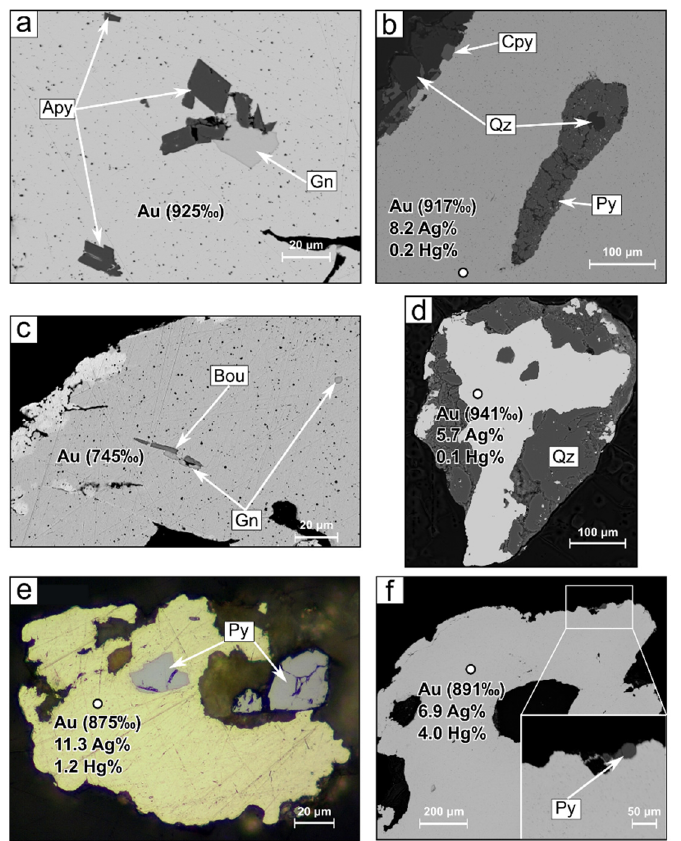
Figure 8. BSE and reflected light microscopy images of mineral inclusions in contact with native gold in Pureo particles. Composition and fineness of the hosting native gold is shown. ( a ) Arsenopyrite (Apy) and galena (Gn) in the particle core. ( b ) Pyrite (Py), chalcopyrite (Cpy) and quartz intergrowths occurring both in core and surface (upper left corner). ( c ) Boulangerite (Bou) and galena (Gn) in particle core. A change in the host native gold composition (rim) is visible as a lighter grey zone in the upper left particle border. ( d ) Quartz present in both core and surface of the particle. ( e , f ) Pyrite (Py) inclusions in contact with native gold cores with >1 Hg